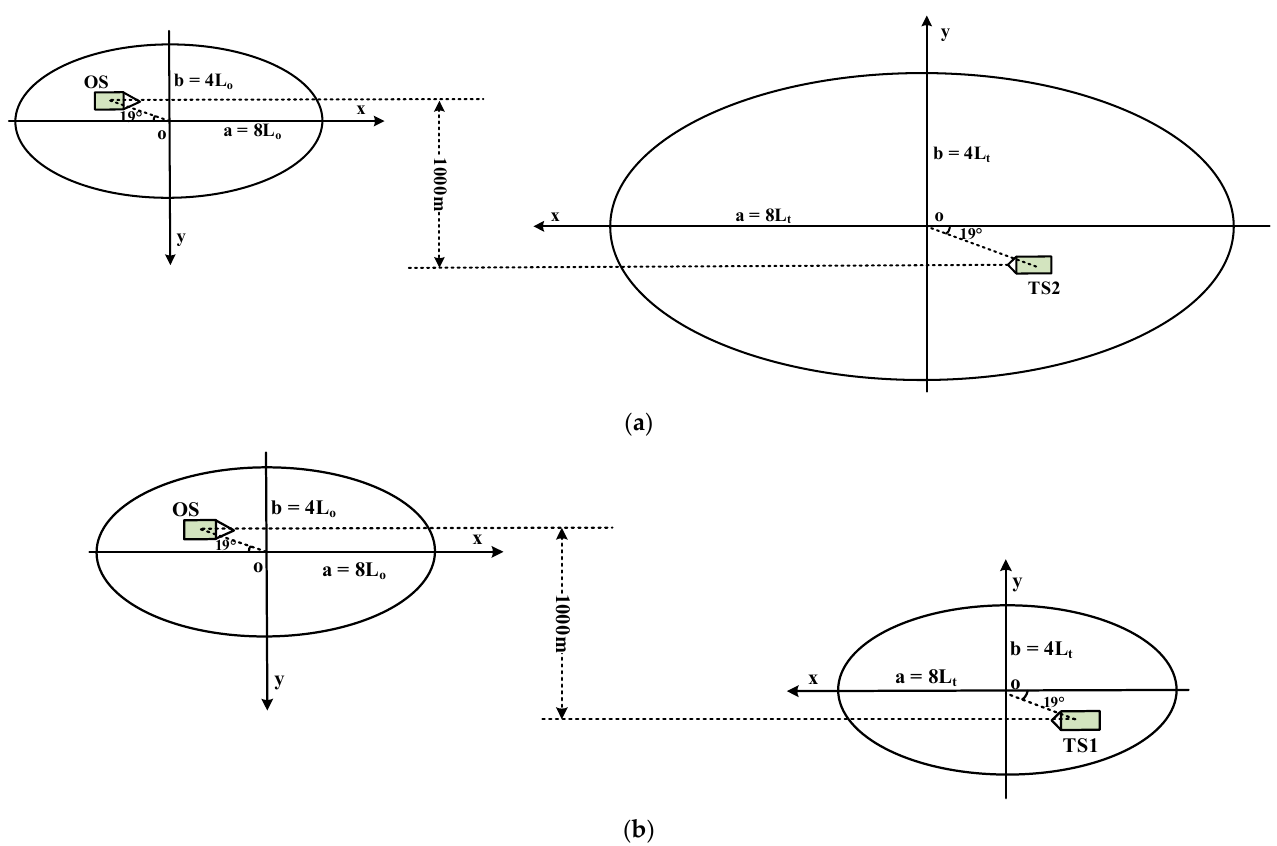
Figure 3. Two different encounters in a head-on situation. The lengths of L o , L t1 and L t2 are 160, 336 and 160 m, respectively. ( a , b ) are variables that can be set accordingly based on the captain’s experience and the ship’s speed. The radius a and b of the elliptical ship domain in this experiment are set to 8 times and 4 times of its own LOA, respectively.